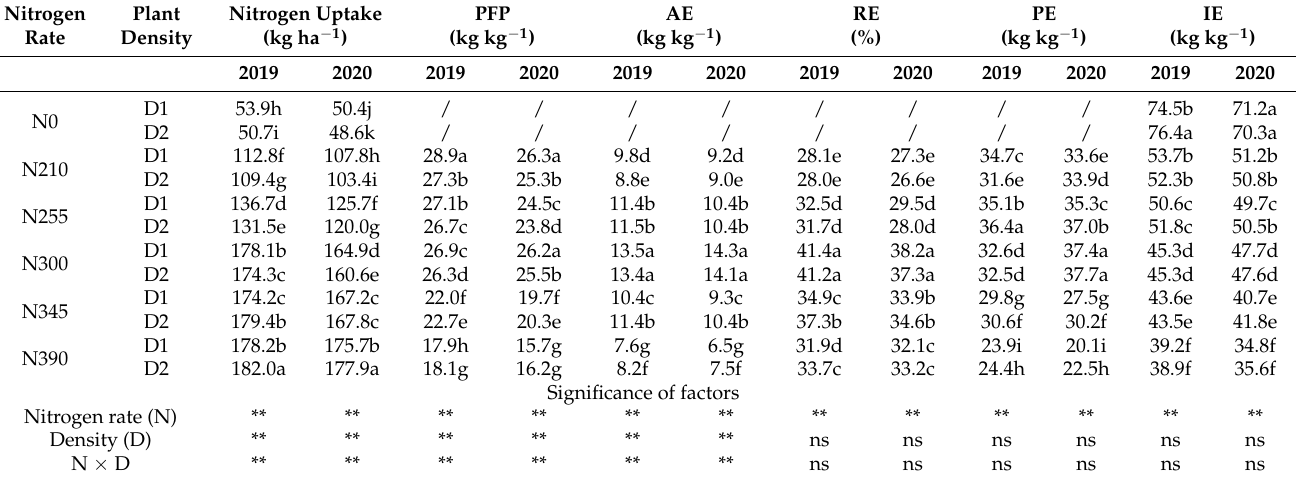
Table 3. The nitrogen uptake, N partial factor productivity (PFP), agronomic N use efficiency (AE), apparent recovery efficiency of N fertilizer (RE), physiological N use efficiency (PE), and internal N use efficiency (IE) under combined nitrogen rate and planting density in saline soil.